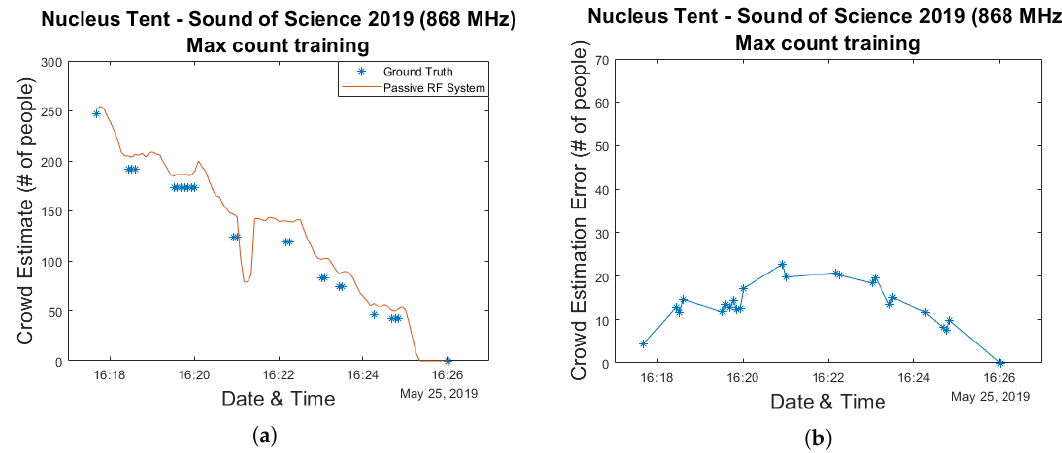
Figure 19. A Crowd estimation graph and its corresponding error graph for a model trained using the max count from the Sound of Science experiments and evaluated based on all remaining data. ( a ) shows the crowd estimation graph and ( b ) shows the error